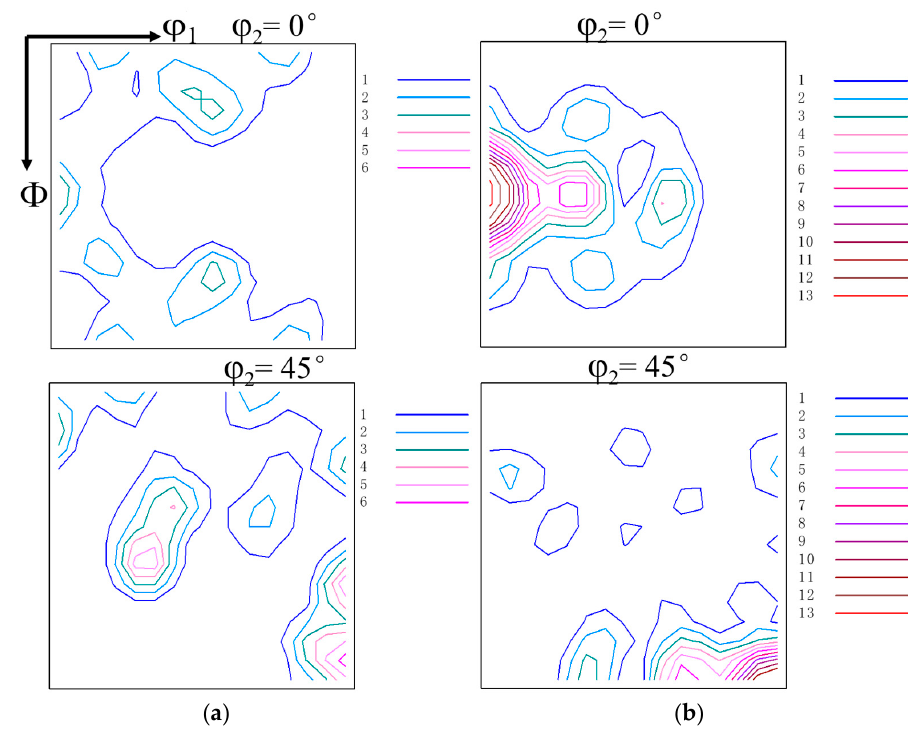
Figure 3. Constant φ 2 = 0° and φ 2 = 45° sections in the sheets annealed at 900 °C for 10 min: ( a ) 0Cu; and ( b ) 0.5Cu.